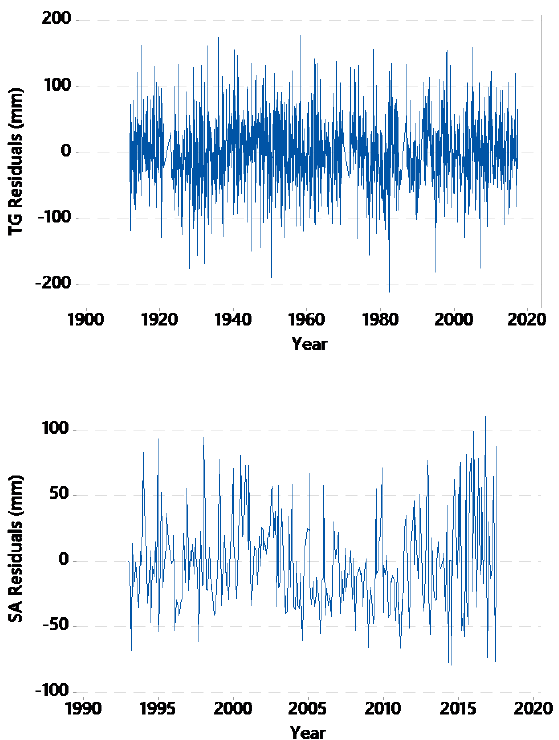
Fig. 3. TG and SA solution residuals calculated using the conflation model.